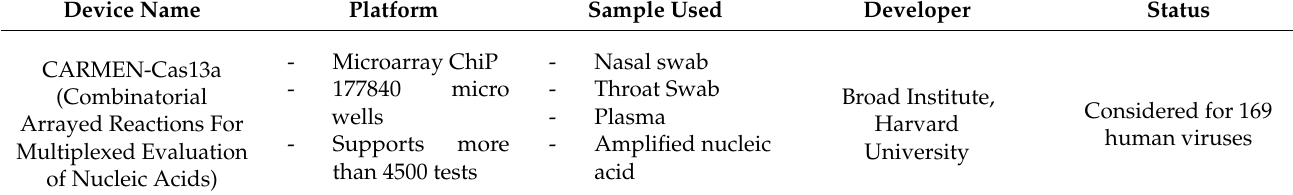
Figure 6. Figure illustrates the list of tests approved by FDA, in 2022. Approximately 239 new molecular diagnostic tests, 34 novel serology and immune response tests, and 90 antigen diagnostic tests have been approved by FDA. Table 2. SARS-CoV-19 advanced diagnostics in development [81].